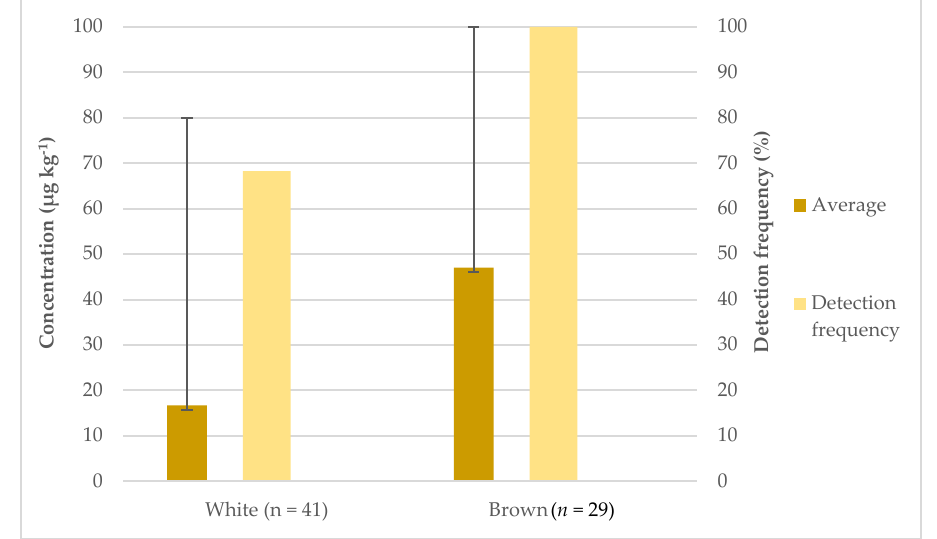
Figure 1. Detection frequency (%), average and maximum concentrations (µg kg −1 ) of inorganic arsenic in white and brown rice.